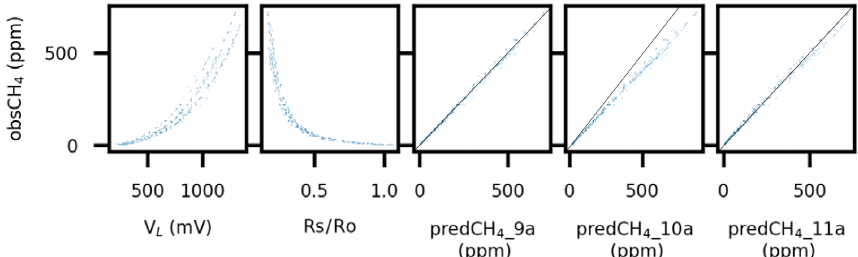
Figure 2. Sensor output voltage ( V L ; mV), R S /R 0 ratio, and predicted CH 4 mixing ratio (predCH 4 ; ppm) using Models 9a, 10a, and 11a in Table 2, respectively, versus observed CH 4 mixing ratio (obsCH 4 ; ppm), for one of the studied sensors. See text for details and Figs. S1 and S2 in the Supplement for similar graphs regarding all sensors. Black diagonals represent 1 : 1 lines.